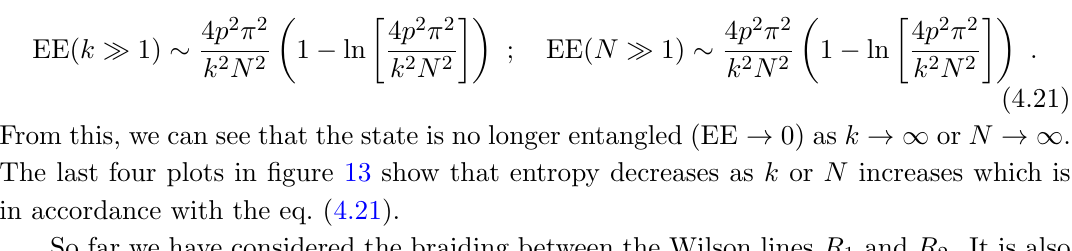
Figure 13 . Variation of SU( N ) k entanglement entropy for the state j (cid:9) p . The horizontal dashed line represents the maximum possible value (ln 2) of